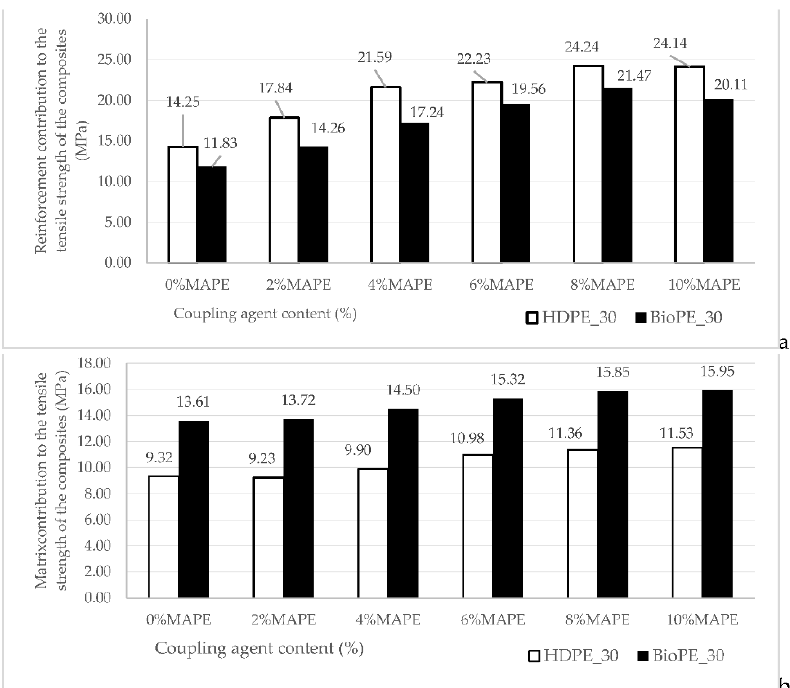
Figure 5. Contribution of the phases to the tensile strength of HDPE and BioPE-based composites, reinforced with 30 wt% of AF against MAPE contents; ( a ) contribution of the reinforcement; ( b ) contribution of the matrix.